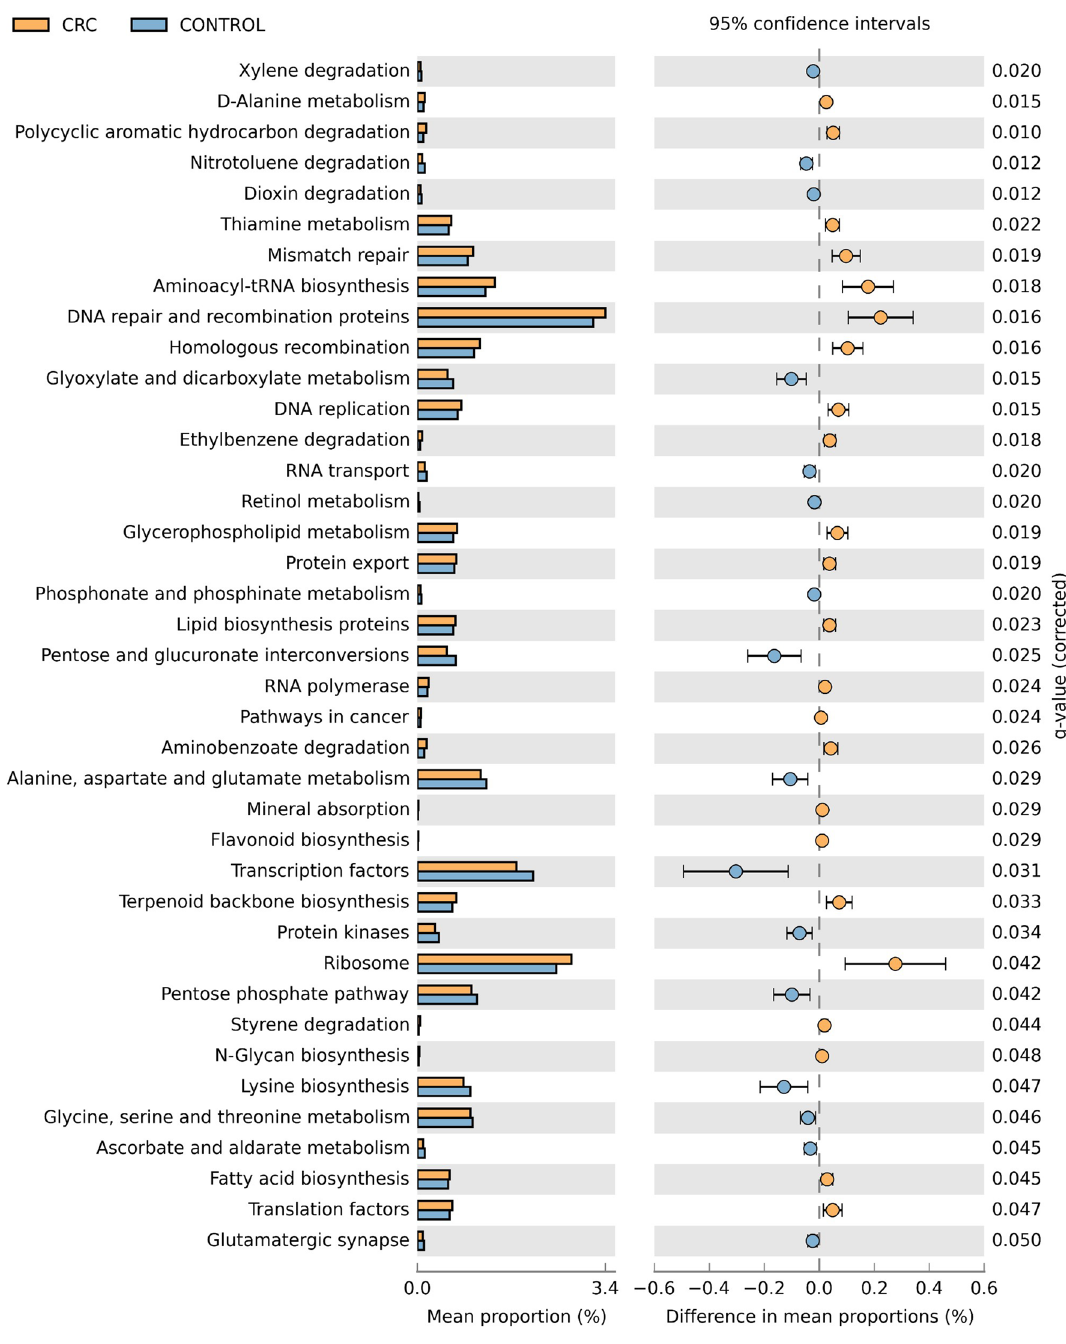
Figure 5. Predicted gut microbiome metabolic functions at KEGG pathway Level 3. PICRUSt and STAMP analyses revealed 39 significantly different metabolic functions based on gut microbiome abundance in CRC versus non-CRC